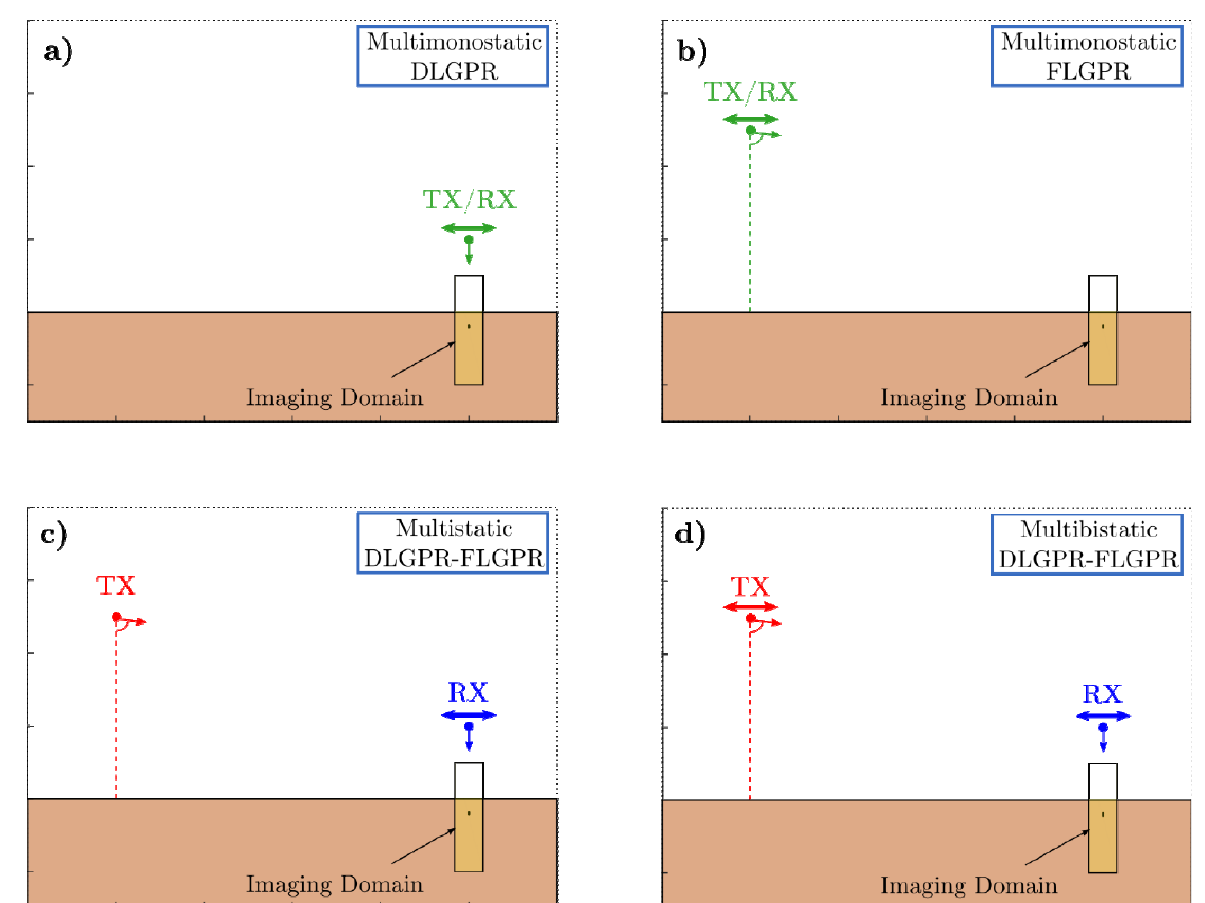
Figure 1. Schemes of different Ground Penetrating Radar (GPR) architectures [21]: conventional Down-Looking GPR (DLGPR) ( a ) and Forward-Looking GPR (FLGPR) ( b ) configuration; proposed hybrid FLGPR-DLGPR architectures in which the transmitter is static ( c ) and the transmitter moves synchronously with the receiver ( d